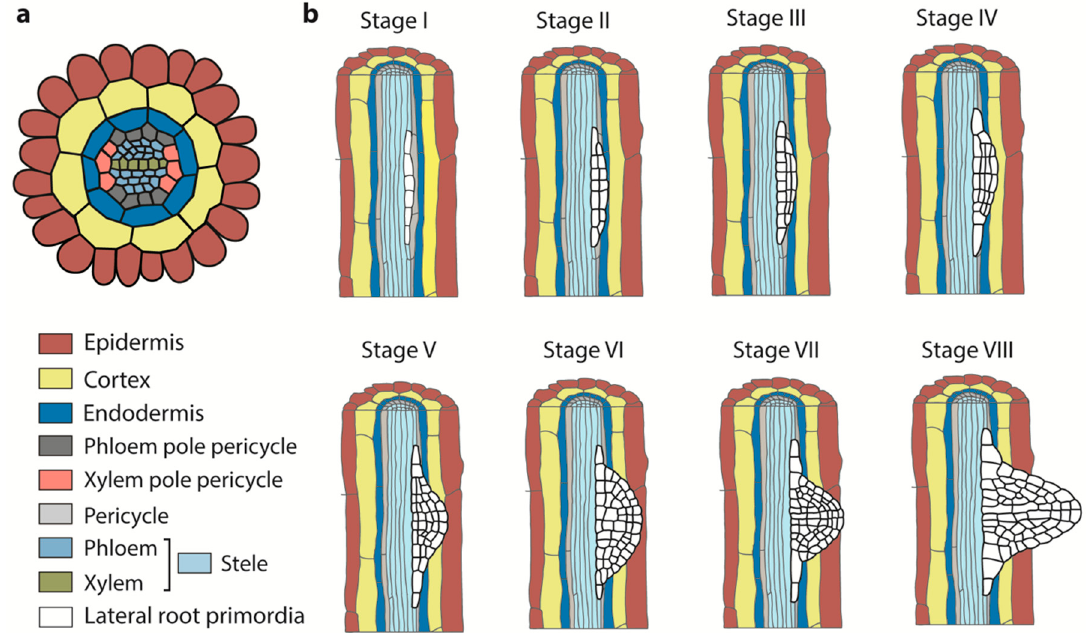
Figure 1. Morphological changes during lateral root (LR) initiation and development. ( a ) Schematic representation of the Arabidopsis primary root cross-section. The root has a simple structure composed of the stele (pericycle and vasculature) surrounded by three one-cell layer, endodermis, cortex and epidermis. ( b ) The eight stages of lateral root initiation and development. Lateral root founder cells (LRFCs, white color in Stage I) are specified in the xylem–pole–pericycle (XPP) and pass through eight developmental stages to emerge at the surface of the root. Stages I–IV take place before the endodermis is traversed and Stages V–VIII take place after the endodermis has been crossed.